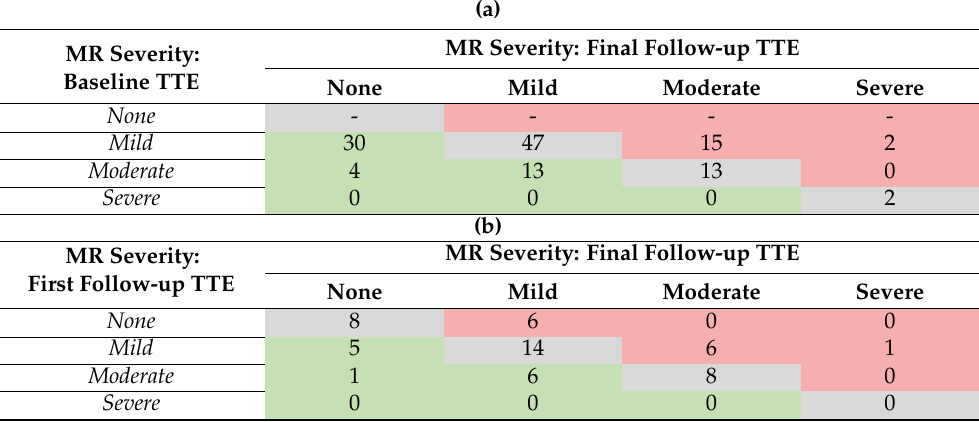
Table 3. (a) MR severity on baseline TTE v final follow-up TTE. (b) MR severity on first follow-up TTE vs. final follow-up